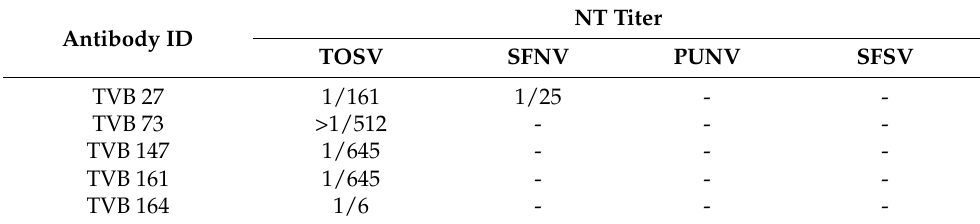
Table 3. Neutralization assay of mAbs against SFNV, PUNV and SFSV.